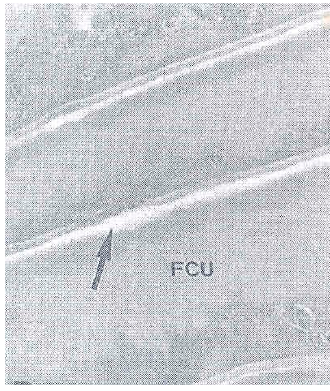
Figure 7. The cell membrane complex in a Maple syrup disease hair showing the disruption of the β -layer on the upper surface of each cuticle cell (FCU). This demontrates that the stability of the layer is dependent upon the preence of 18-MEA. From reference